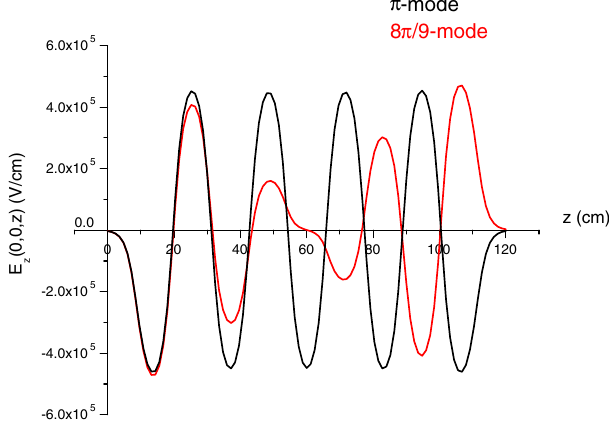
FIG. 3. (Color) Accelerating field distribution along the ILC cavity operating on (cid:1) -mode and 8 (cid:1)= 9 -mode.